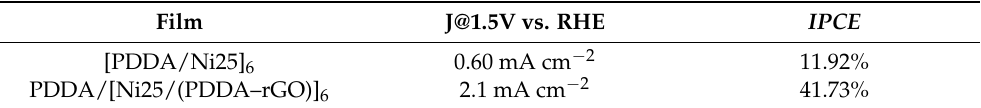
Figure 9. Transient photocurrent response of the film [PDDA/Ni25] n ( n = 1, 3, 5) ( left ) and the film PDDA/[Ni25/(PDDA − rGO)] n ( n = 1, 3, 5) ( right ) at 1.0 V vs. time (i − t) curve with a 30 s light on/off. Further, it is obviously seen in Figure 9 that on the films assembled with different layers, the photogenerated currents increase as the number of layers increases regularly, and the change trend of the curves remains unchanged. This observation indicates that, on the one hand, the fabrication and performance of the two composite films have repeatability, and the two composite films are assembled uniformly, that is, the photogenerated currents versus the number of film layers have a good linear relationship,